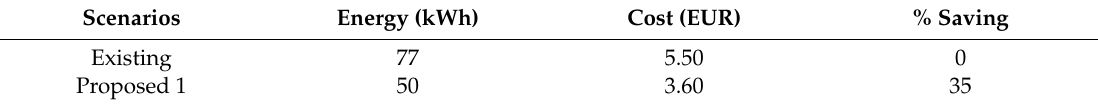
Table 2. Comparison of the proposed and existing energy, and cost management for